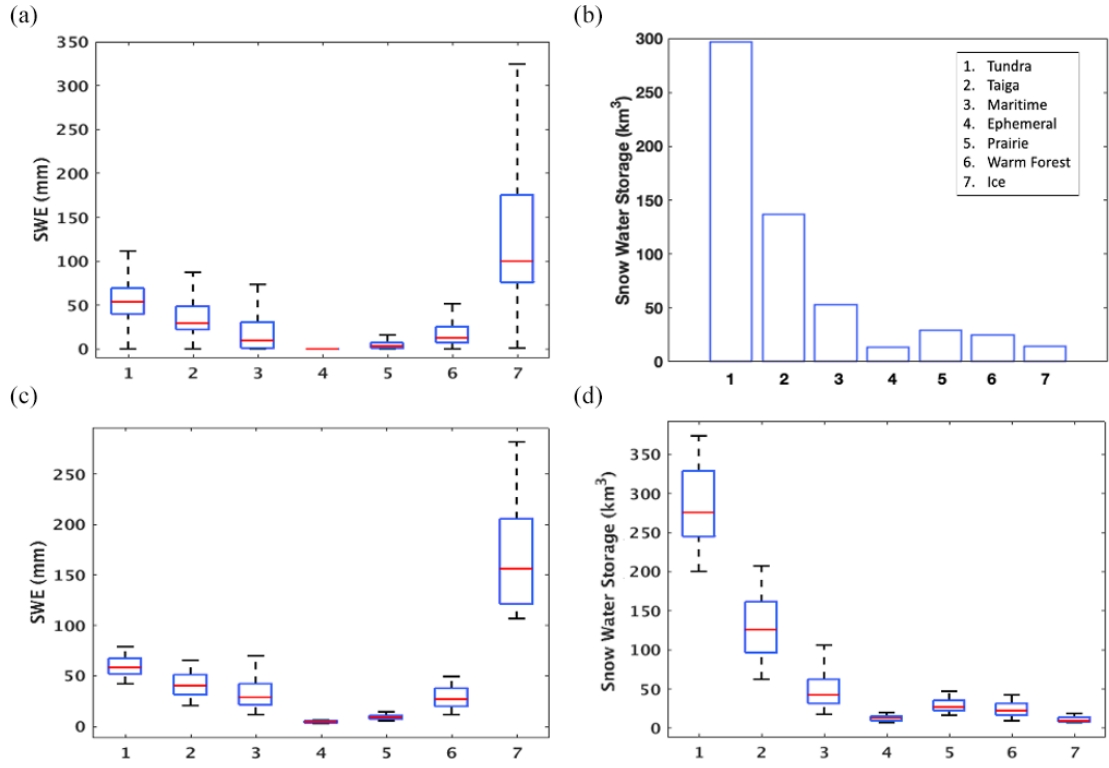
Figure 9. Same as Fig. 7 but for each snow